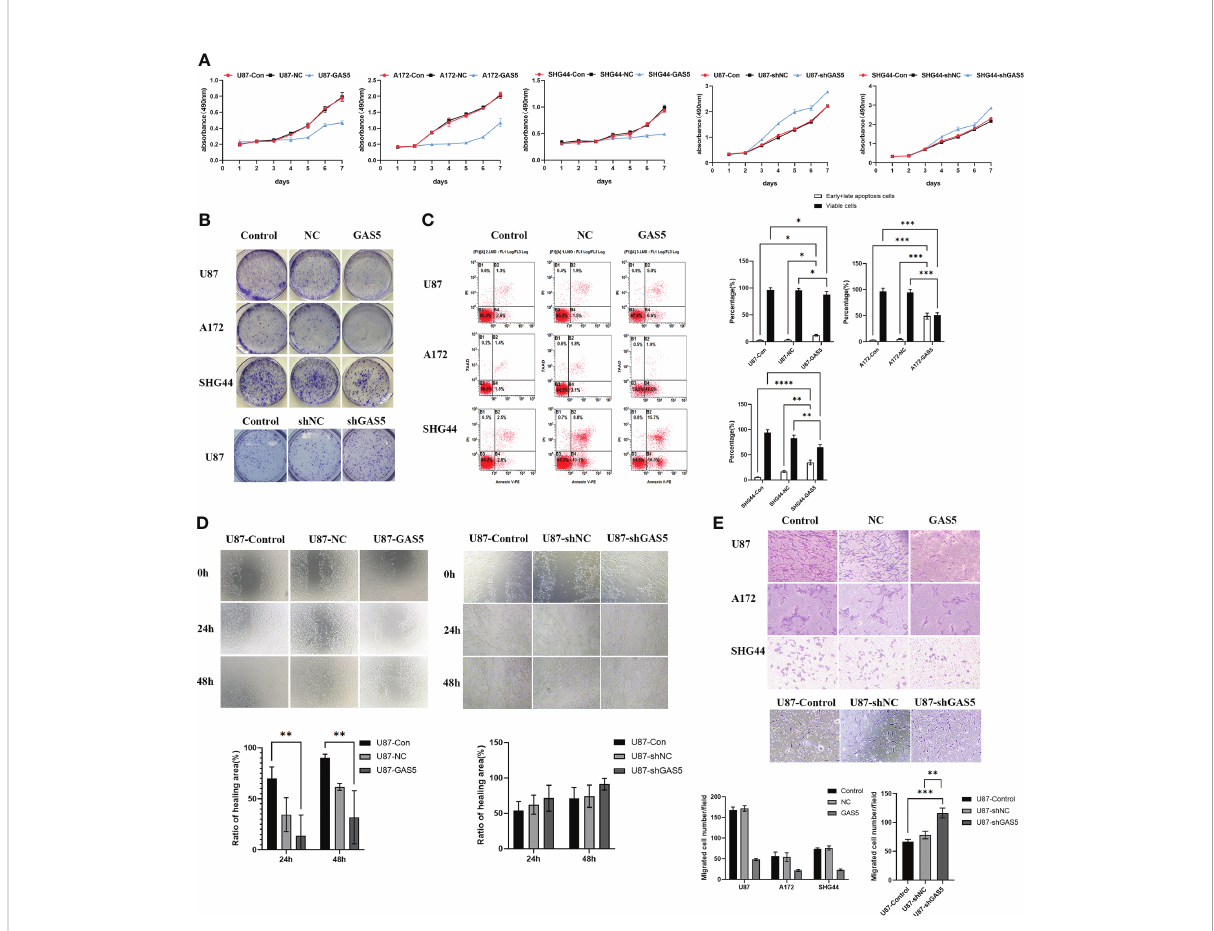
FIGURE 2 LncRNA-GAS5 overexpression diminished cell viability and suppressed the migration and invasion of GBM cells. (A) CCK-8 assay revealed the effect of GAS5 overexpression and knockdwon on the proliferation of parental U87, A172 and SHG44 cell lines with the cells are cultured for seven consecutive days and the absorbance of the cells are measured daily (n=6). (B) Colony formation assay of GAS5 overexpression and knockdwon and parental GBM cell lines (n=3). Representative images are shown. (C) Flow cytometric analysis of apoptosis in GAS5 overexpression and knockdwon and parental GBM cell lines (n=3). The statistical result of the fl ow cytometric analysis is shown. (D) Scratch test showed the healing ability of U87 cells (n=3). Representative images and the ratio of healing area are shown. (E) Transwell assay of the effect of GAS5 on the migration and invasion of GBM cells (n=3). Representative images and the migration cell number are shown. Data are presented as the mean ± S.D. P value is determined by Student ’ s t test (*P < 0.05, **P < 0.01, ***P < 0.001,